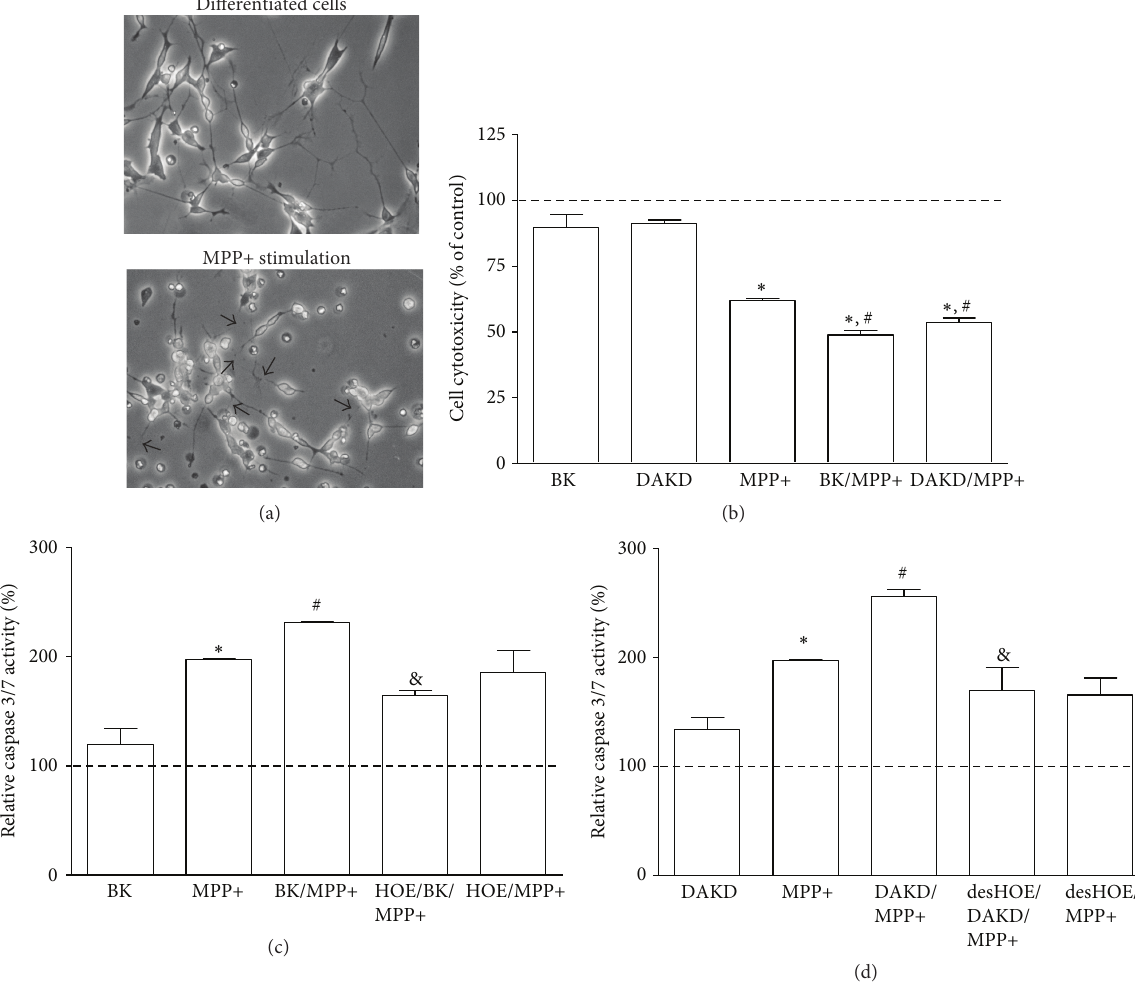
Figure 1: The effect of kinin peptides on apoptotic processes in the PD cellular model. Visualization of the SK-N-SH cells differentiated for 3 days with 5 𝜇 M RA with following MPP+ treatment for 24 hours. The destroyed neurites are indicated with arrows (a). RA-differentiated cells after 24 h incubation with 1 𝜇 M BK or 1 𝜇 M DAKD were stimulated (or not) with 2.5 mM MPP+ for one day. Figures illustrate the percentage cell viability assayed with AlamarBlue test (b) or caspase 3/7 activity analyzed with chemiluminescent assay (c, d) as compared to untreated samples, assumed to show values equal to 100% (dashed line), as described in Materials and Methods. At least three experiments were performed in triplicate. ∗ 𝑃 < 0.05 versus untreated cells; # 𝑃 < 0.05 versus MPP+-stimulated cells; & 𝑃 < 0.05 versus cells treated with kinin peptides and